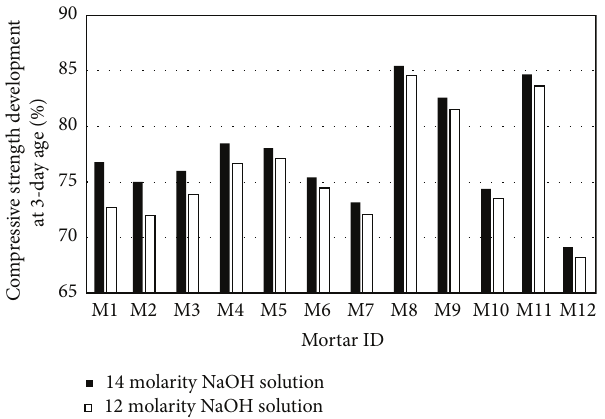
Figure 11: Effect of molarity of alkaline activated solution in compressive strength.